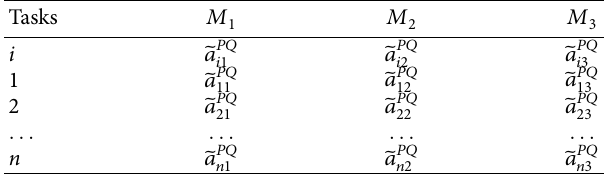
Table 2: Description of the problem with the PQFN matrix. Tasks